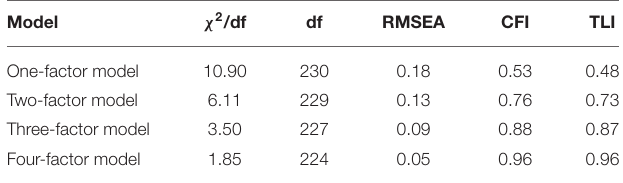
TABLE 1 | Comparison of measurement